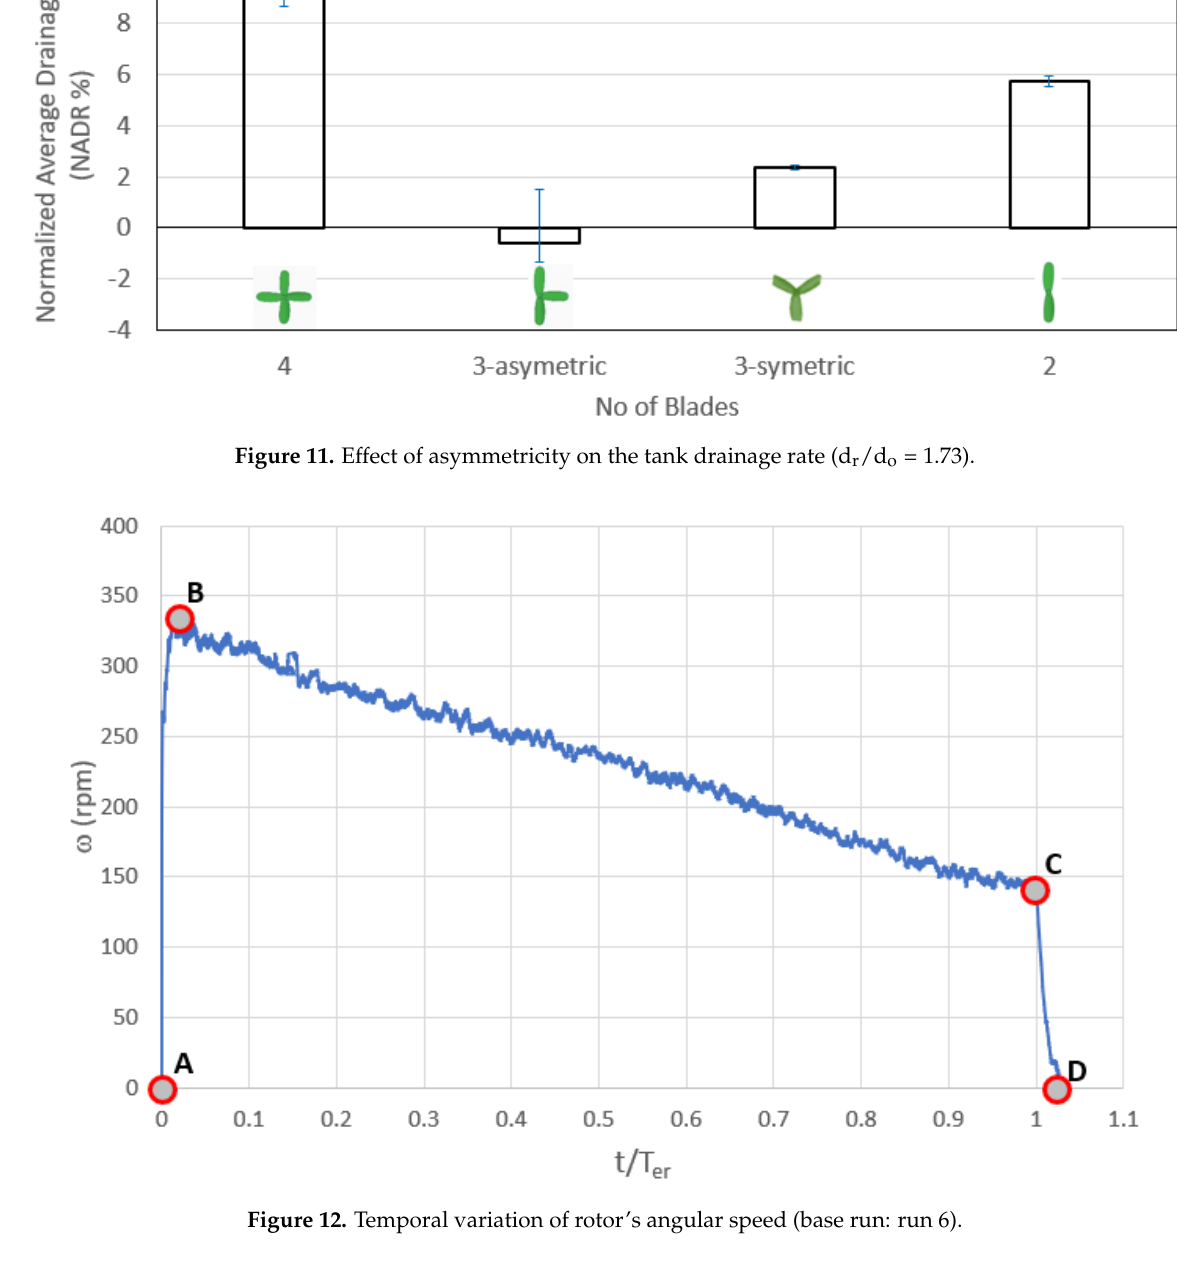
Figure 11. Effect of asymmetricity on the tank drainage rate (dr/do = 1.73).